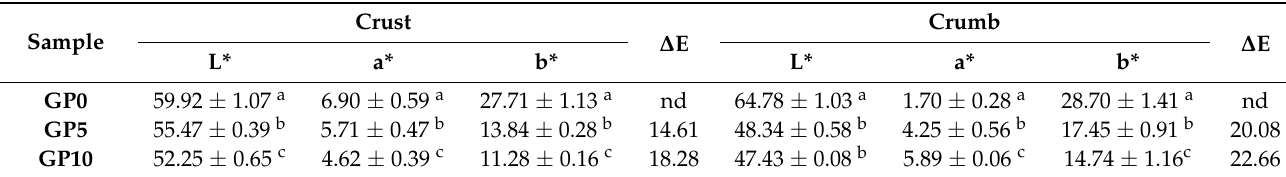
Table 6. Color analysis of bread samples expressed as L*(lightness), a* (red/green), and b* (blue/yellow) values. ∆ E (total color